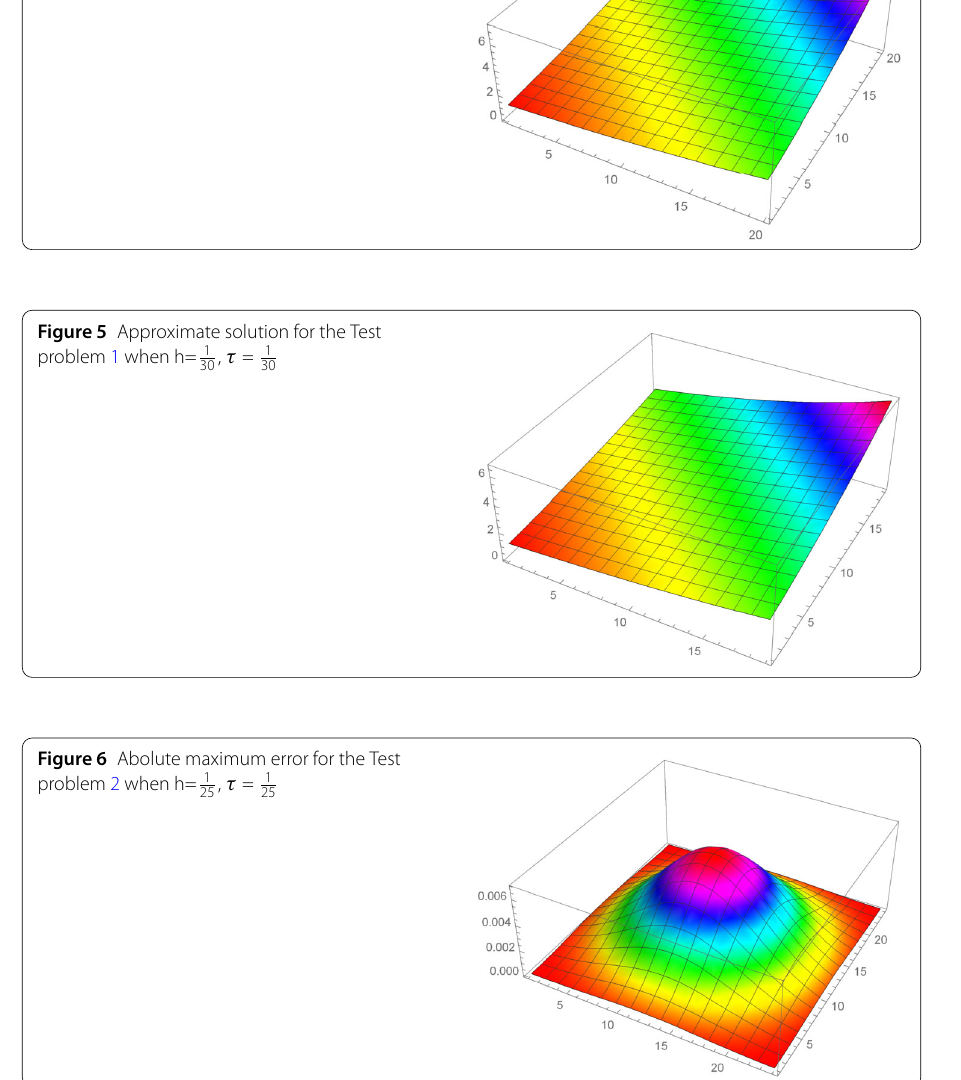
Figure 4 Exact solution for the Test problem 1 , τ = 1 when h= 1 30 30